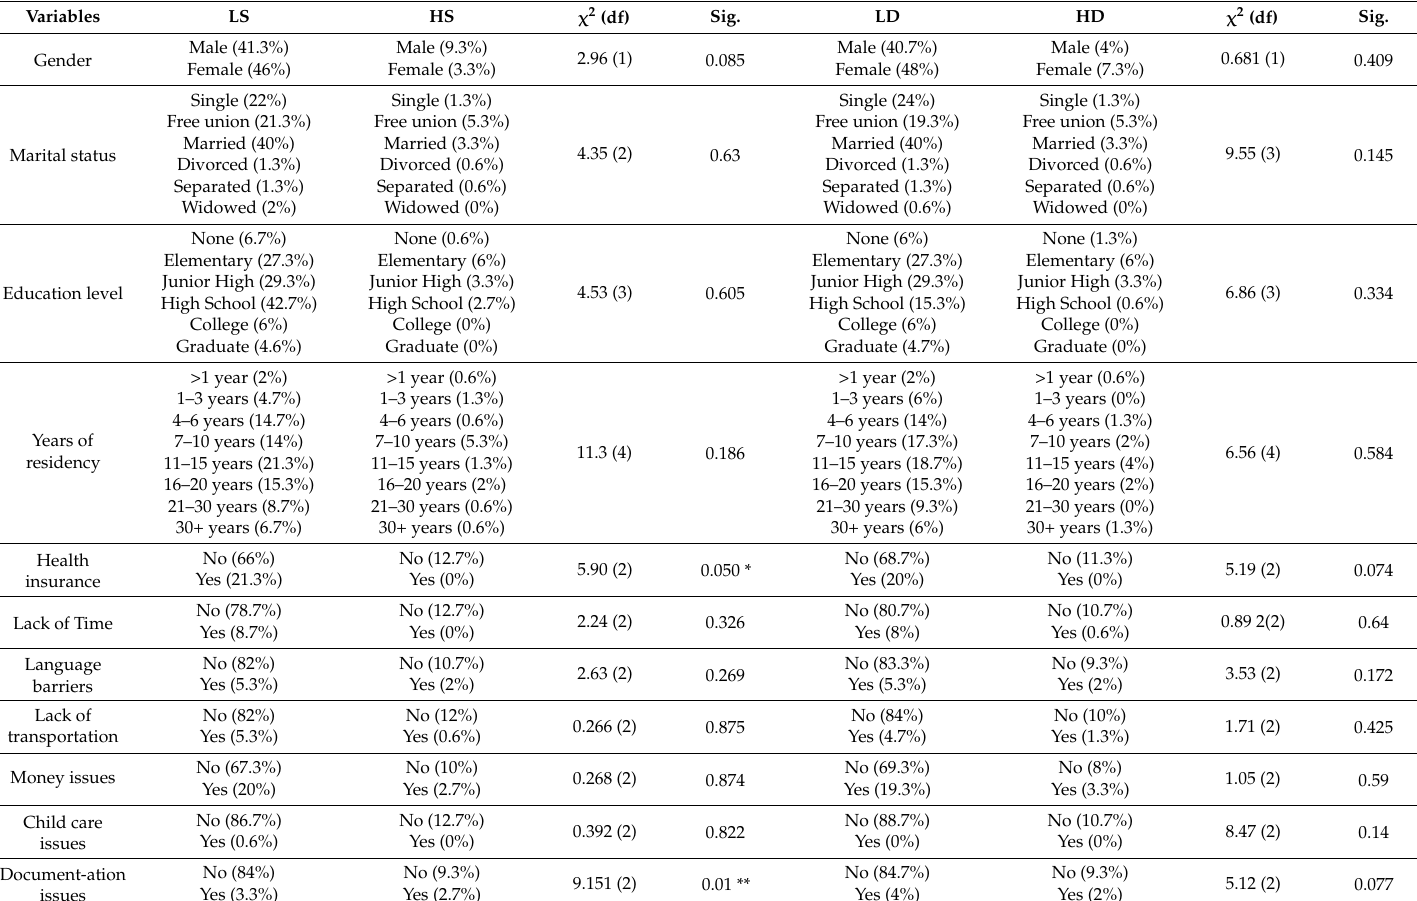
Table 2. Bivariate analyses of covariates between participants with high stress (HS) versus low stress (LS) and high levels of depressive symptoms (HD) versus low levels of depressive symptoms